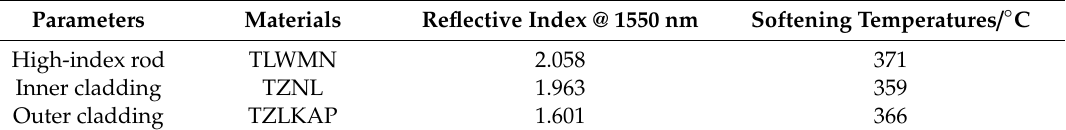
Table 1. Reflective indices and softening temperatures of TLWMN, TZNL, and TZLKAP glasses.